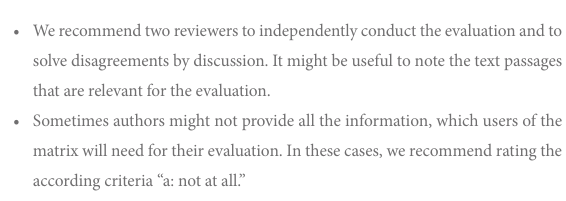
be included in the systematic review of Bolte et al. while for the review of Rompel et al. it was sufficient if sex/gender-specific effect estimates were calculated in the study. Both tables have in common that none of the included publications achieved a rating better than “a: not at all” for any of the four criteria (1) “Precise use of sex/gender-specific terminology used,” (2) “Sex/gender mentioned in the title,” (6) “Sex/ gender considered in formulating the hypotheses” and (10) “Consideration of sex/gender variety and